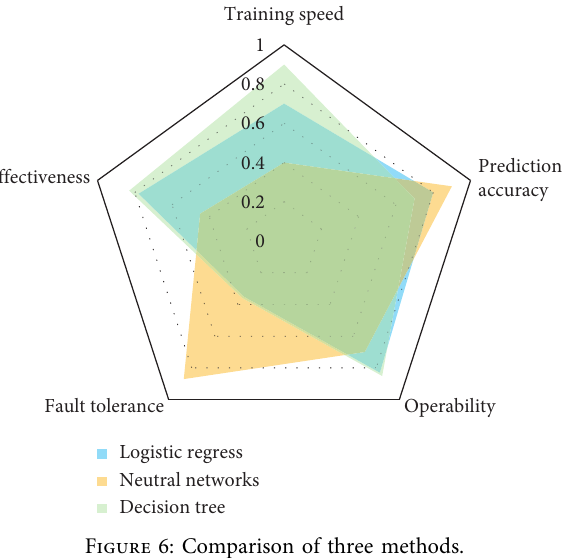
Figure 6: Comparison of three